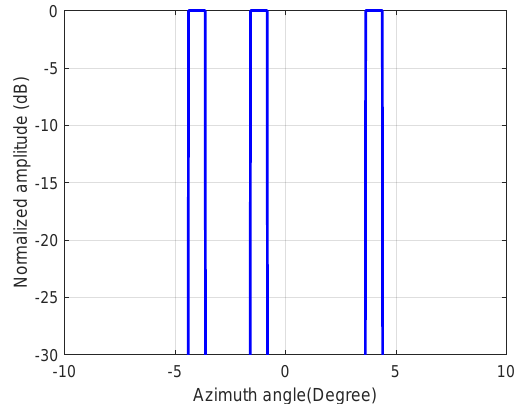
Figure 4. Real scene of